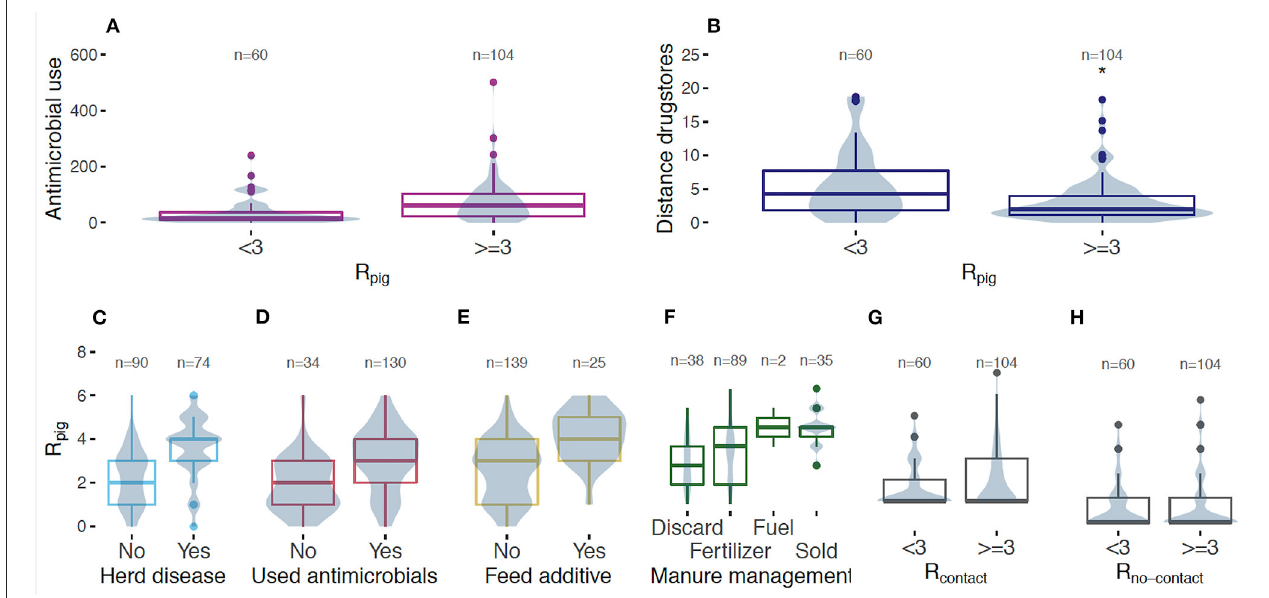
FIGURE 2 | E. coli resistance in pig samples at the farm level in Khon Kaen, Thailand. Medians, interquartile range, minimum, and maximum of (i) the antimicrobial use (cost of antimicrobials per pig) (A) and the minimum distance (in Km) to drugstores (B) between farms that presented R pig ≥ 3 or R pig < 3; (ii) the R pig between farms reporting herd disease or not (C) , between farms reporting to have used antimicrobials or not (D) , use of antimicrobials added in the feed or not (E) , between categories of manure management (F) , and between farms where R contact (G) and R no − contact (H) ≥ 3 or < 3. Distribution of the data points is represented by the violin plot in blue. Colored frames indicate that comparison between groups is significant with p -value < 0.05 by the Wilcoxon rank sum test or Kruskal Wallis test. Gray frames mean absence of significant